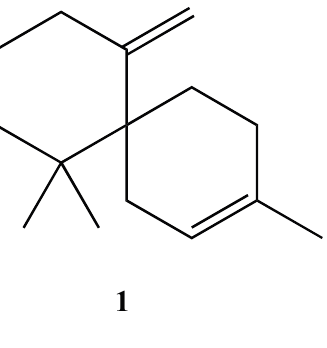
Figure 1. The structure of β